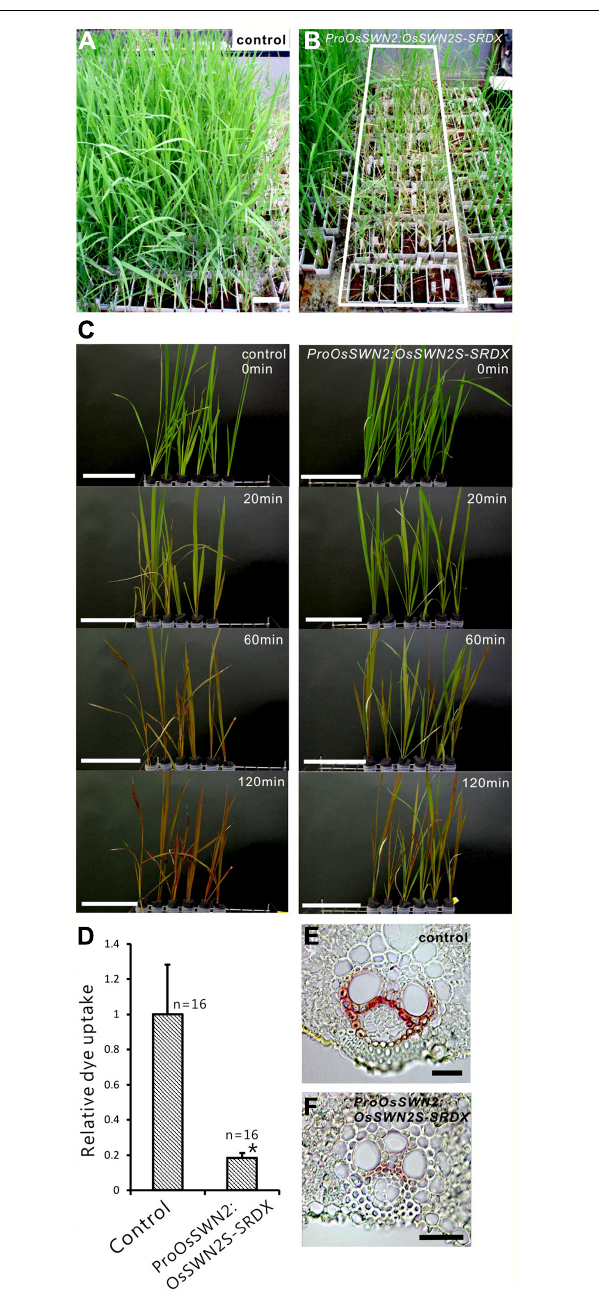
FIGURE 4 | ProOsSWN2:OsSWN2S-SRDX rice plants are defective in water transport . (A) ProOsSWN2:GUS rice plants (control). (B) ProOsSWN2:OsSWN2S-SRDX rice plants, indicated by the white rectangle. (C) Time-course examination of water uptake of shoots excised from the ProOsSWN2:OsSWN2S-SRDX plants before the onset of leaf rolling (1–2 weeks culture after budding).Water with a red tracer dye was used in the experiment. Bars in (A–C) represent 10 cm. (D) Relative dye uptake by ProOsSWN2:OsSWN2S-SRDX plants compared to control plants (set to 1). Error bars represents standard error. “*” indicates values considered to be significantly different from control byWelch’s t -test with P < 0.05. (E, F) Cross sections of leaf of control plants (E) and ProOsSWN1:OsSWN2S-SRDX rice plants (F) stained with phloroglucinol to detect lignin. Bars in (E, F) represent 100 μ